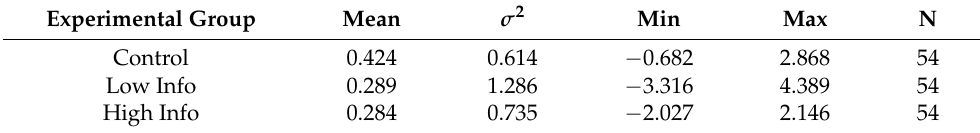
Table 1. Asks’ sensitivity to market price: The β parameter across experimental groups. Experimental Group